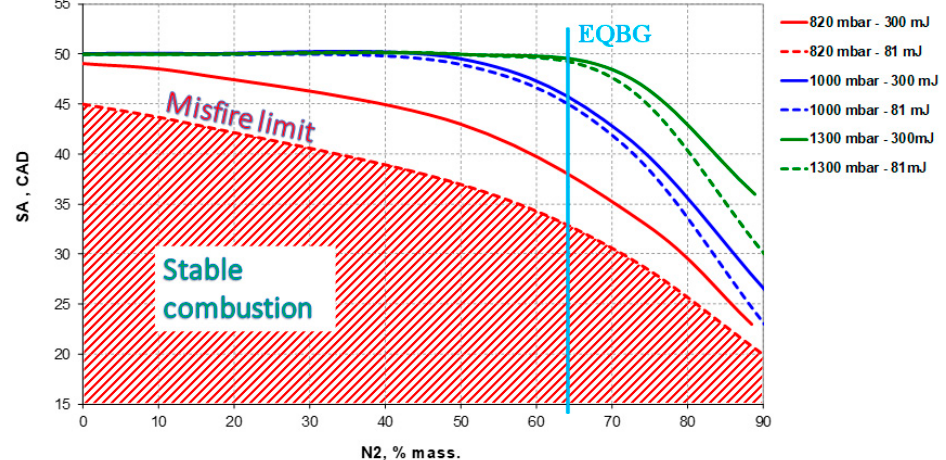
Figure 12. SA limit for combustion stability of CH 4 as a function of the N 2 mass fraction dilution.